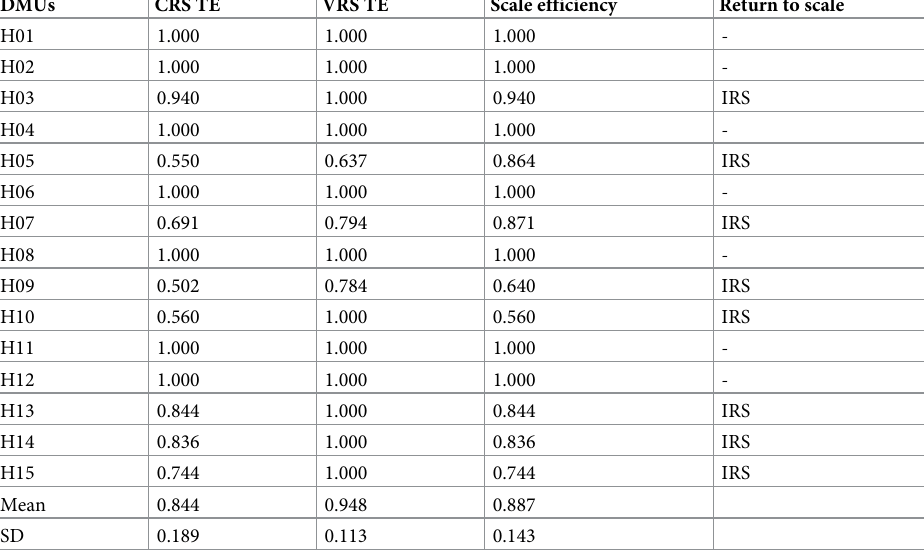
Table 3. Efficiency scores of primary hospitals towards the provision of neonatal health services in three zones of Northwest Ethiopia, 2021 (N = 15 DMUs).